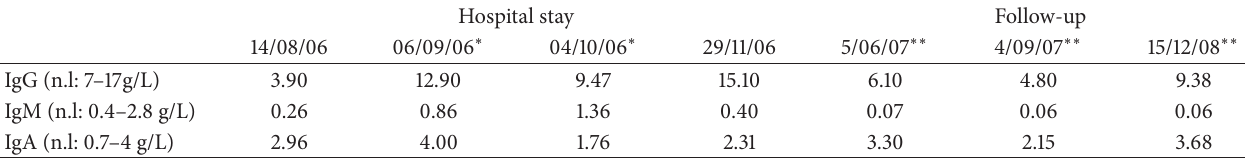
Table 1: Immunoglobulin levels during hospital stay and follow-up. Hospital stay